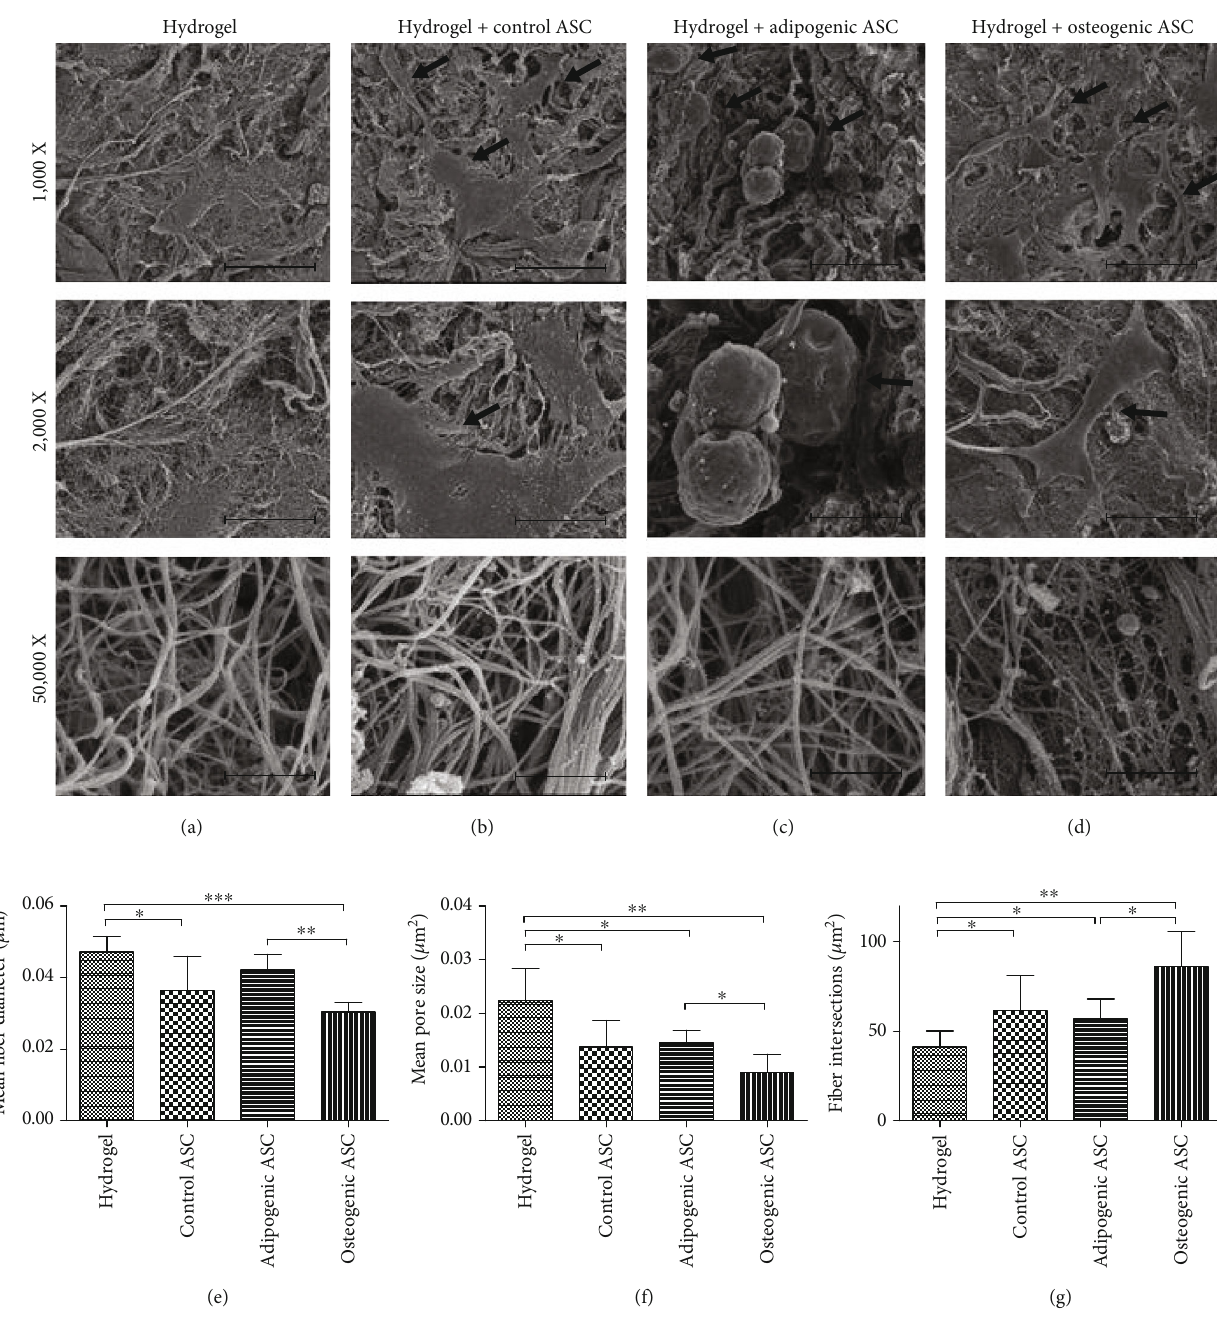
Figure 5: Analysis of ASC and DAT hydrogel fi ber morphology using images acquired by SEM. (a-d) Representative SEM images of DAT hydrogel (no cells) (a), control ASC (b), adipogenic ASC (c), and osteogenic ASC (d) seeded DAT hydrogels are displayed at 3 magni fi cations; 1,000X (Arrows indicate cells; Scale bar 50 μ m), 2,000X (magni fi ed to display cell morphology; Scale bar 20 μ m), and 50,000X (magni fi ed to display fi ber morphology; Scale bar 1 μ m). Fiber morphology metrics were measured from 50,000X images using ImageJ software (diamterJ plugin) to determine mean fi ber diameter (e) mean pore size (f), and fi ber intersections/ μ m 2 (g). Data are expressed as mean ( n = 6 ) ± SD; level of signi fi cance: ( ∗ ) p < 0 : 05 ; ( ∗∗ ) p < 0 : 01 ; ( ∗∗∗ ) p < 0 : 001